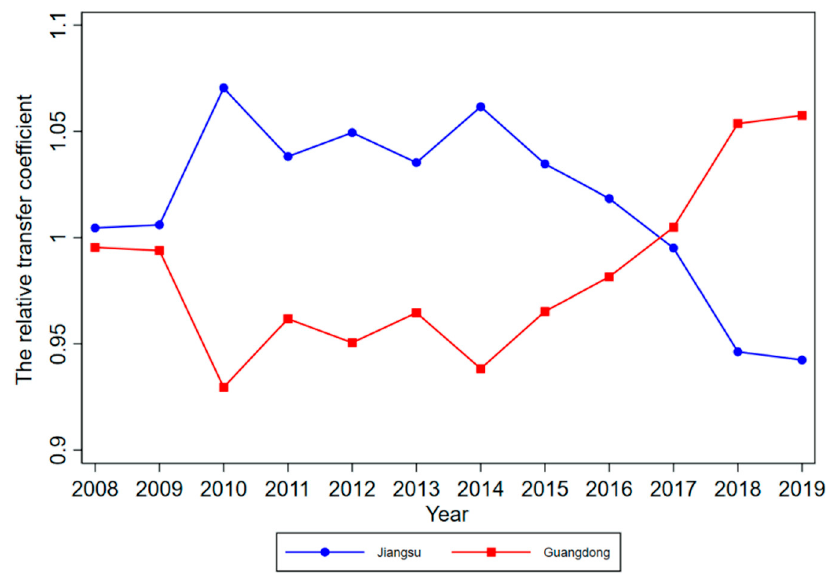
Figure 4. Relative transfer paths of HQDM levels in Club 1 member provinces.